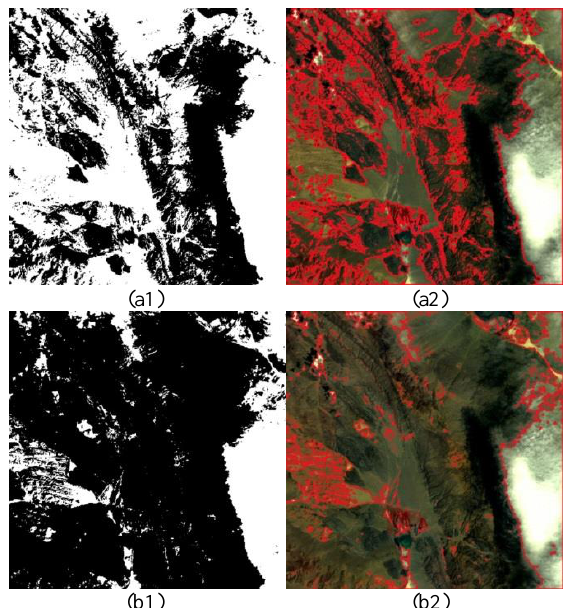
Figure 5. SVM detection comparisons. (a) Result before optimization. (b) Result after the